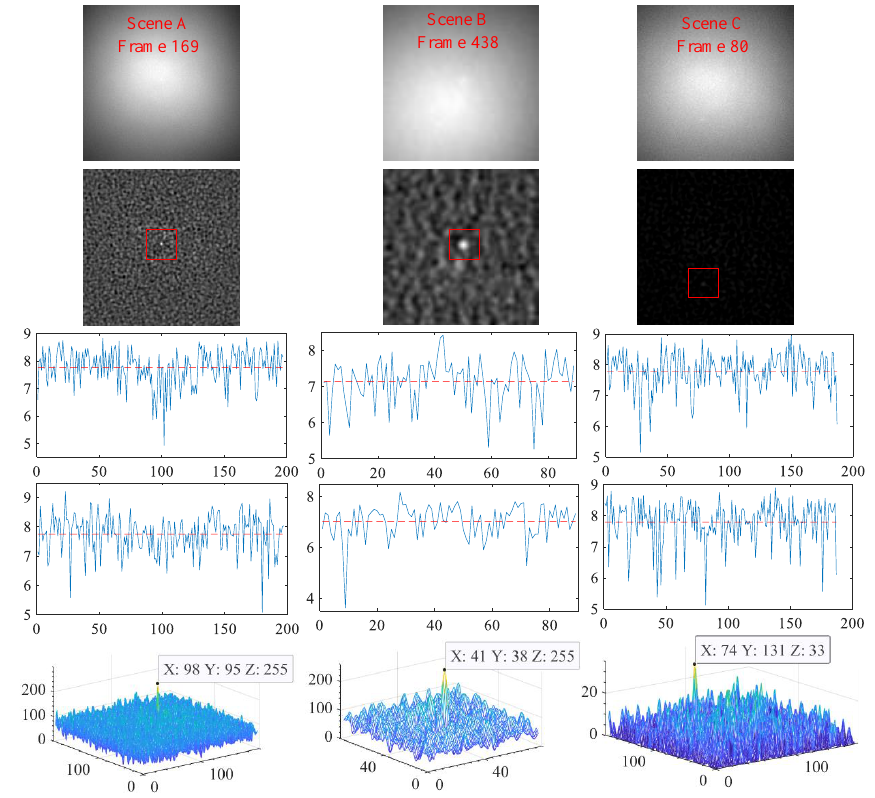
Figure 11. Whitening effect of the residual